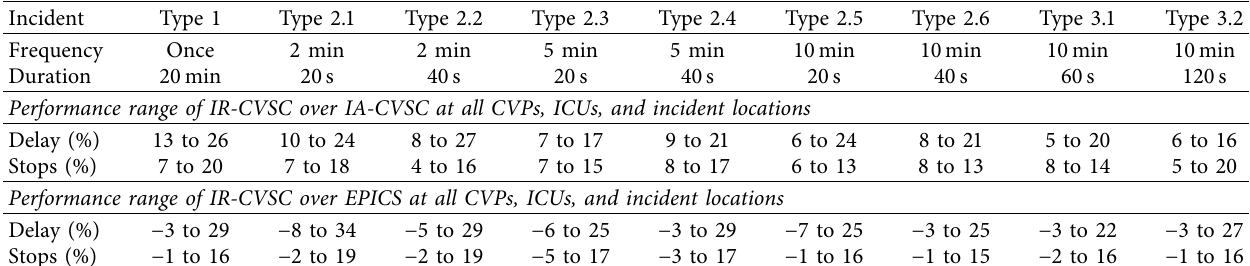
Figure 9: Percent change in IR-CVSC delays and stops with change in CVP, ICU, and incident’s location from the stop-line. Table 4: Signal control MOEs’ evaluation at all CVPs, ICUs, and incident